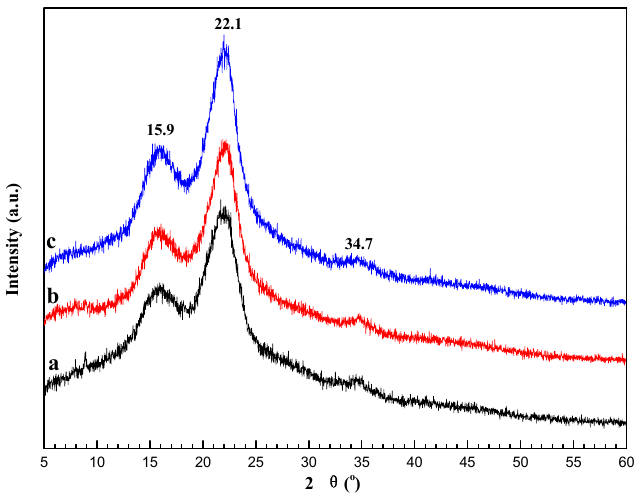
Figure 2. XRD patterns of SCB ( a ), fresh SCB-NH 2 ( b ), and recovered SCB-NH 2 ( c ).